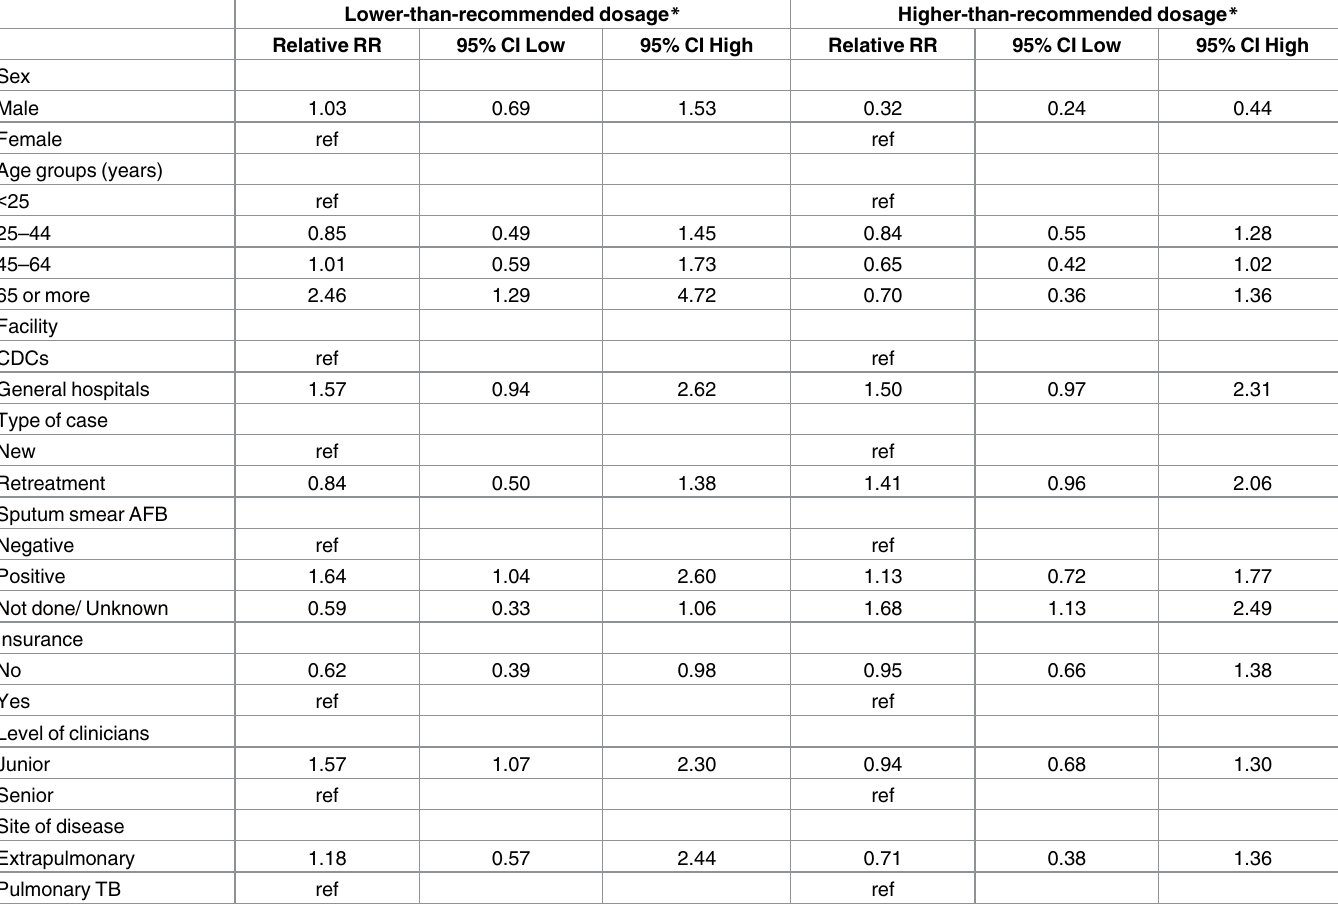
Table 9. Factors associated with inadequate dosing of pyrazinamide,